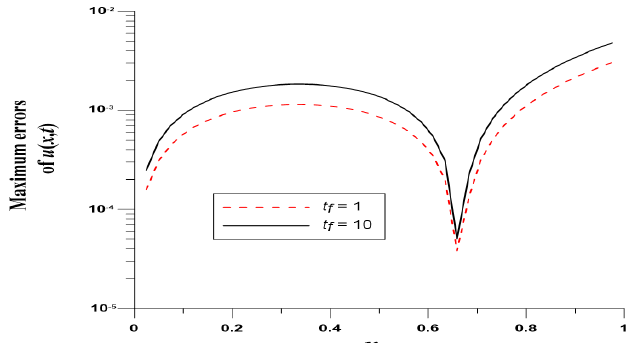
Figure 10. For Example 5 of the backward nonlocal wave problem: ME( u ) versus x with different final times.